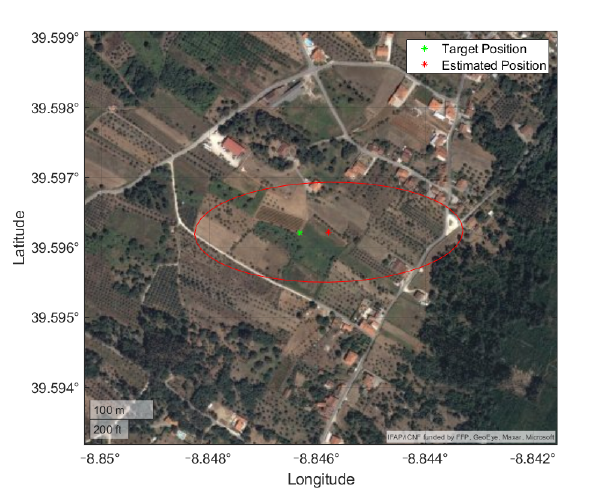
Figure 14. Mean position and uncertainty from experimental procedure with real data displayed on a satellite view of the terrain.